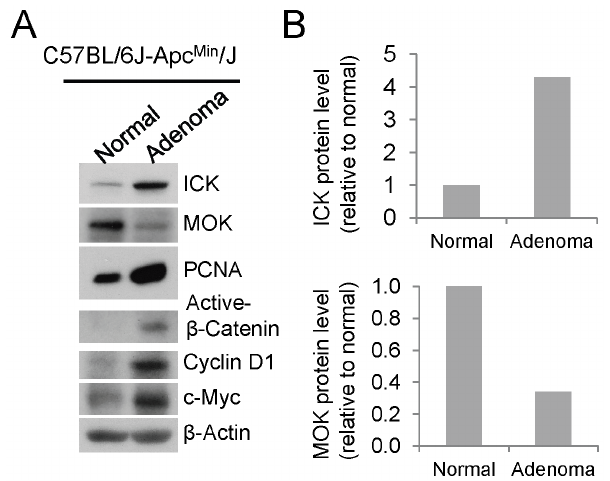
Figure 7. ICK and MOK proteins displayed opposite expression patterns in mouse intestinal adenomas. (A) Tissue specimens macro-dissected from intestinal adenomatous polyps and their adjacent normal mucosa were obtained from C57BL/6J-Apc min /J mice (The Jackson Lab). Equal amount of total proteins (30 m g) from tissue extracts were Western blotted against ICK and MOK antibodies respectively. PCNA signal was shown as a proliferation marker to indicate malignant proliferation in the intestinal adenomas. Western signal of b -Actin was shown to indicate equal loading of total proteins. (B) Western blot signals of ICK and MOK were quantified by densitometry and normalized against the b -Actin signal. Shown here were the protein levels of ICK and MAK in intestinal adenomas relative to their adjacent normal tissues.